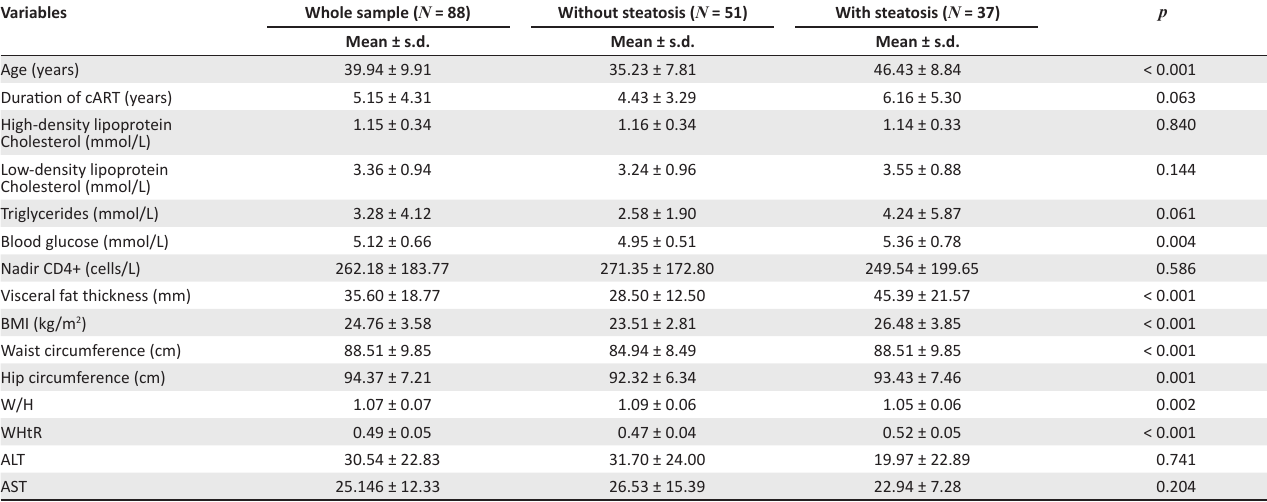
TABLE 1: Clinical and demographic data of the patients with the presence of steatosis.